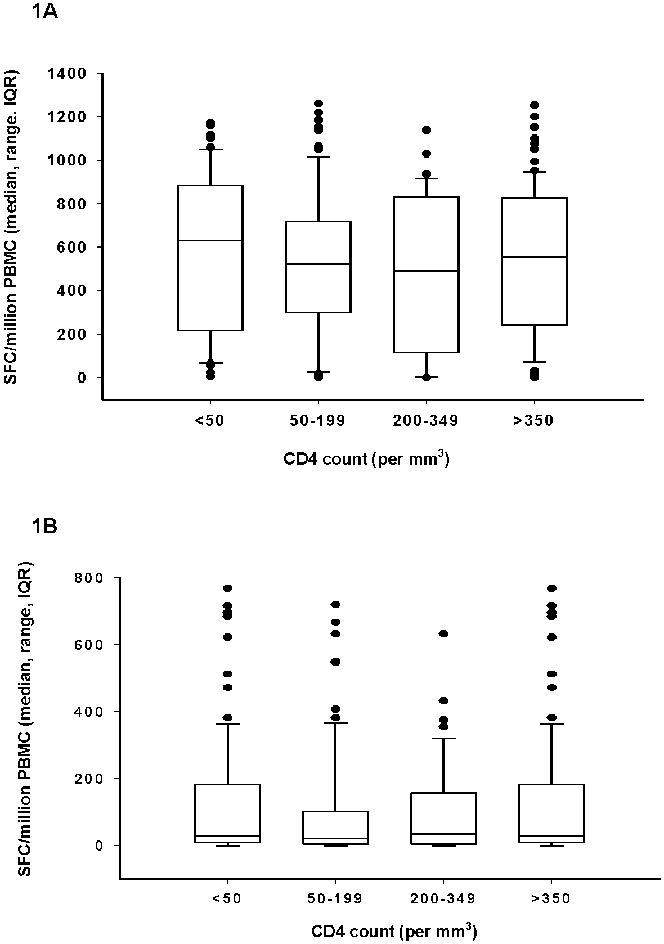
Distribution of responses to PHA and ESAT6/CFP10 ELISPOT assays in HIV patients, by CD4 cell count (boxplot showing median, IQR and range) (n = 285).1A: Distribution of responses to PHA. 1B: Distribution of responses to ESAT6/CFP10.